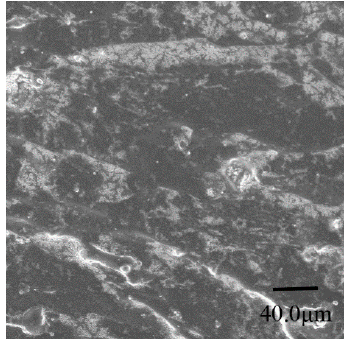
Figure 1. The microstructure of polyurea under SEM.